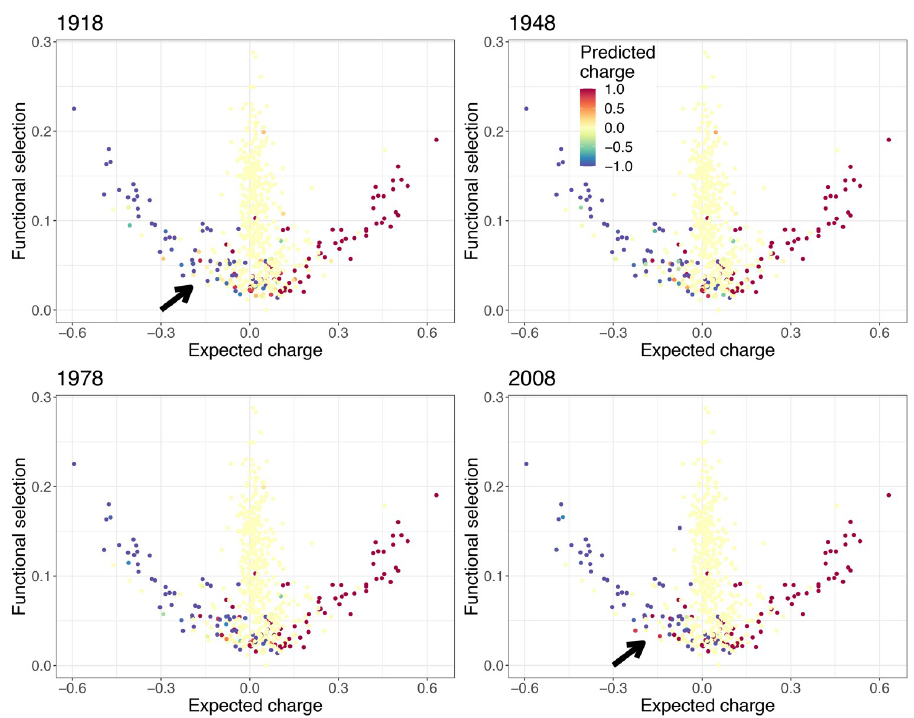
Fig 5. Fitted observed charge in 1918, 1948, 1978, and 2008 computed from fitted per-site multinomial logistic regression models. These models were fitted using nnet [30] in R [31] (see Materials and methods). All 1744 human HA H1N1 sequences between 1918 and 2008 from fludb [28] were used to fit these statistical models. The arrow is used to highlight sites in the negative branch that are transitioning to positive values.